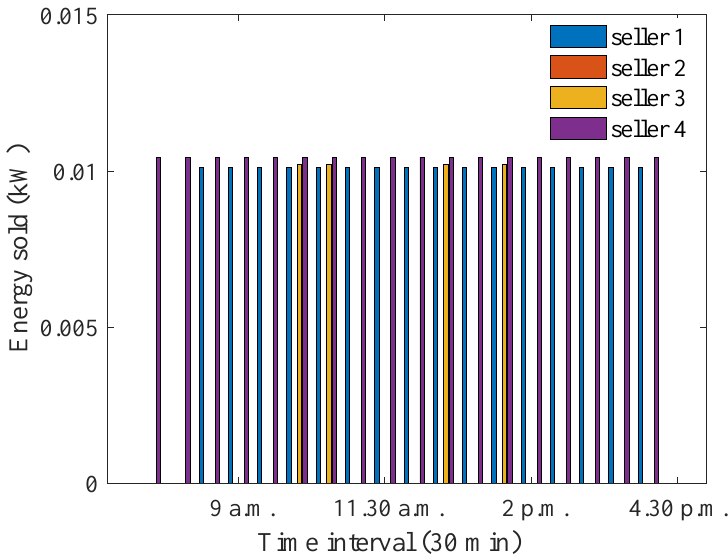
Figure 31. Optimum energy sold for equally preferred sellers and buyers when when profit threshold is increased to a larger value.